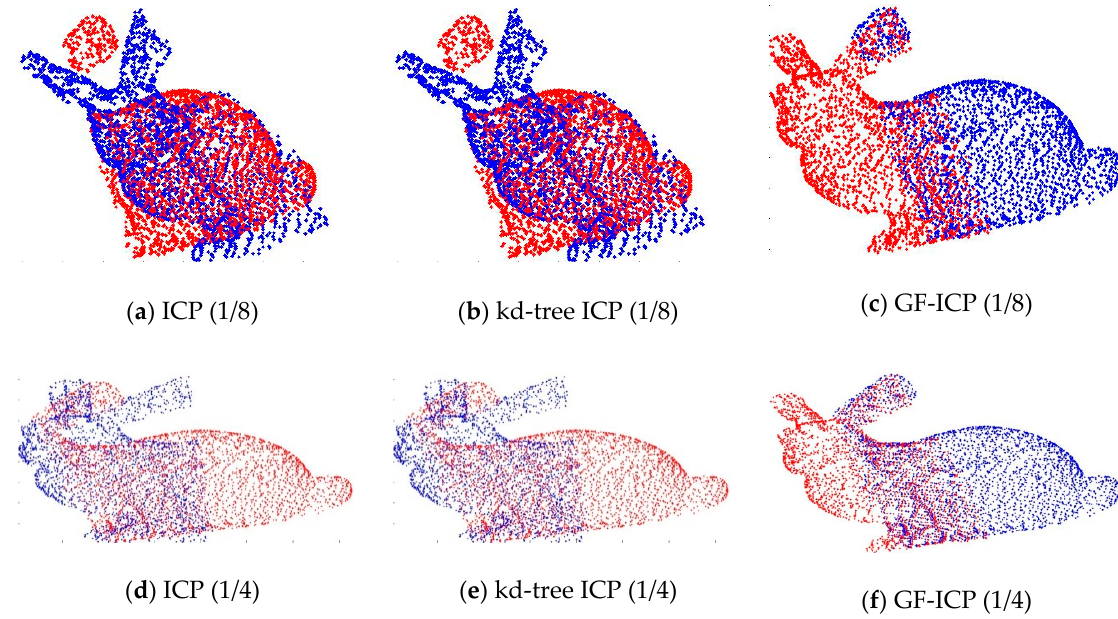
Figure 11. Partial cloud overlap registration results.